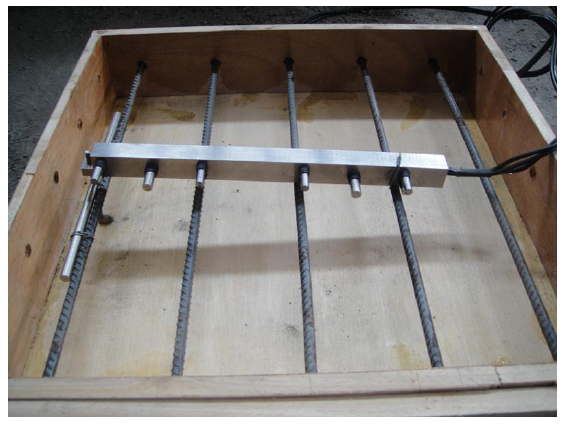
Figure 6. Sensor